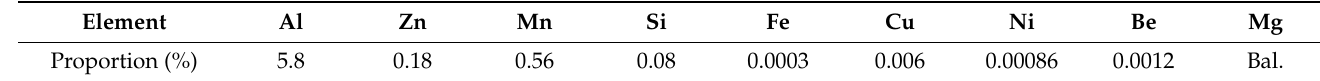
Table 1. Chemical composition of diecast AM60B